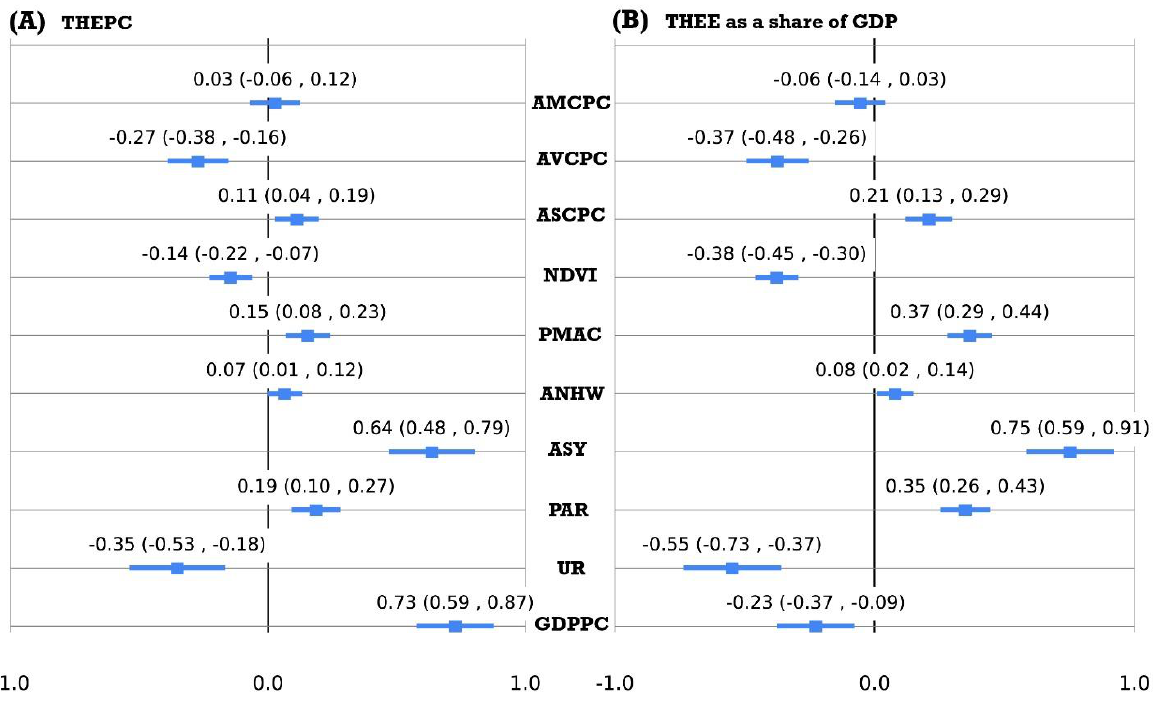
Figure 8. Forest plotting and estimations of the normalized Bayesian LASSO regression coefficients between the 10 independent variables: GDPPC, UR, PAR, ANHW, PMAC, NDVI, ASCPC, AVCPC, AMCPC, and THEPC ( A ) and THEE as a share of GDP ( B ).